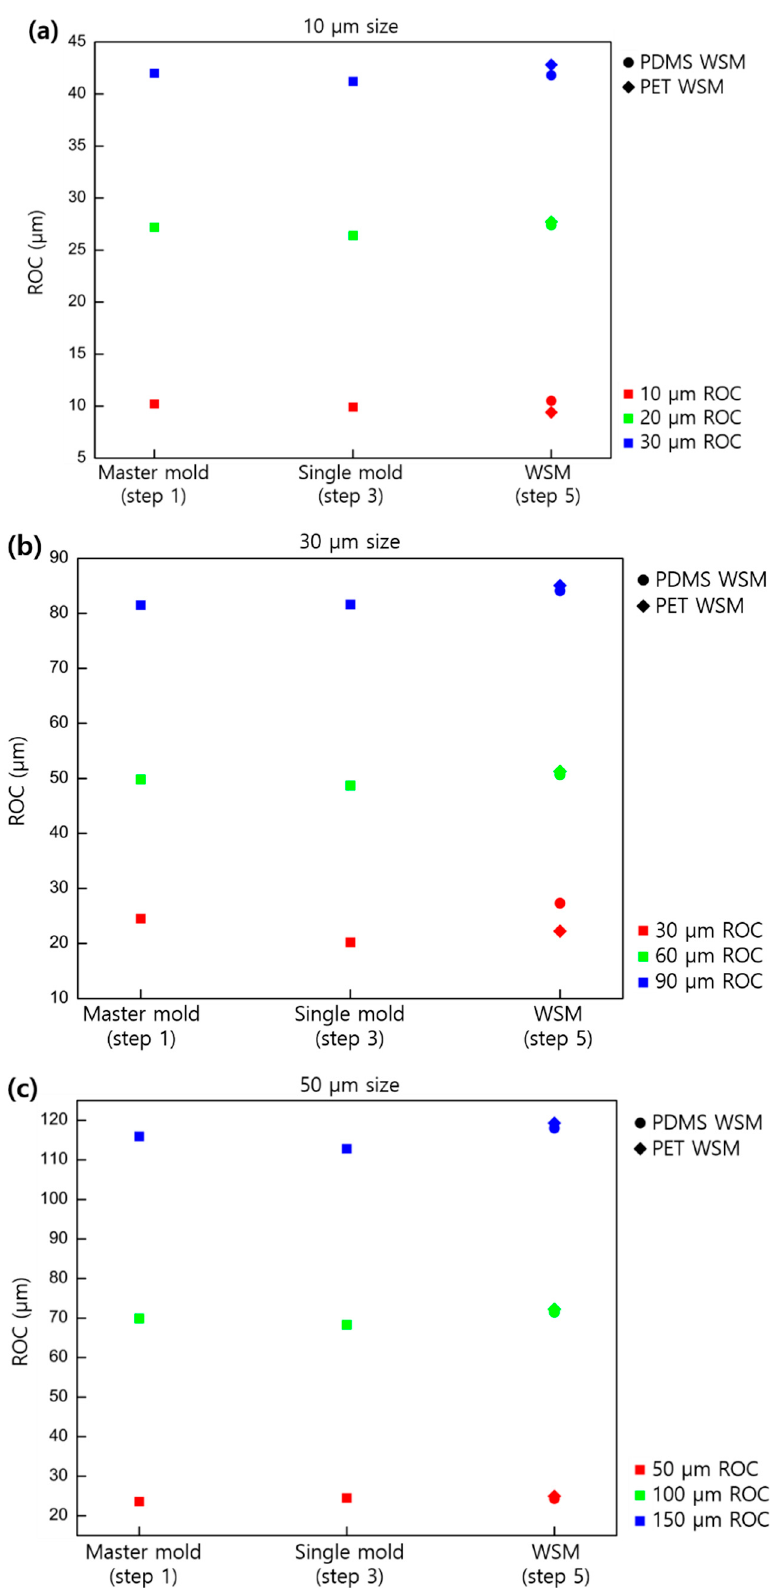
Figure 5. ROC of lens variances based on lens size and shapes for the convex replicated samples: ( a ) 10, ( b ) 30, and ( c ) 50 µm in pitch.